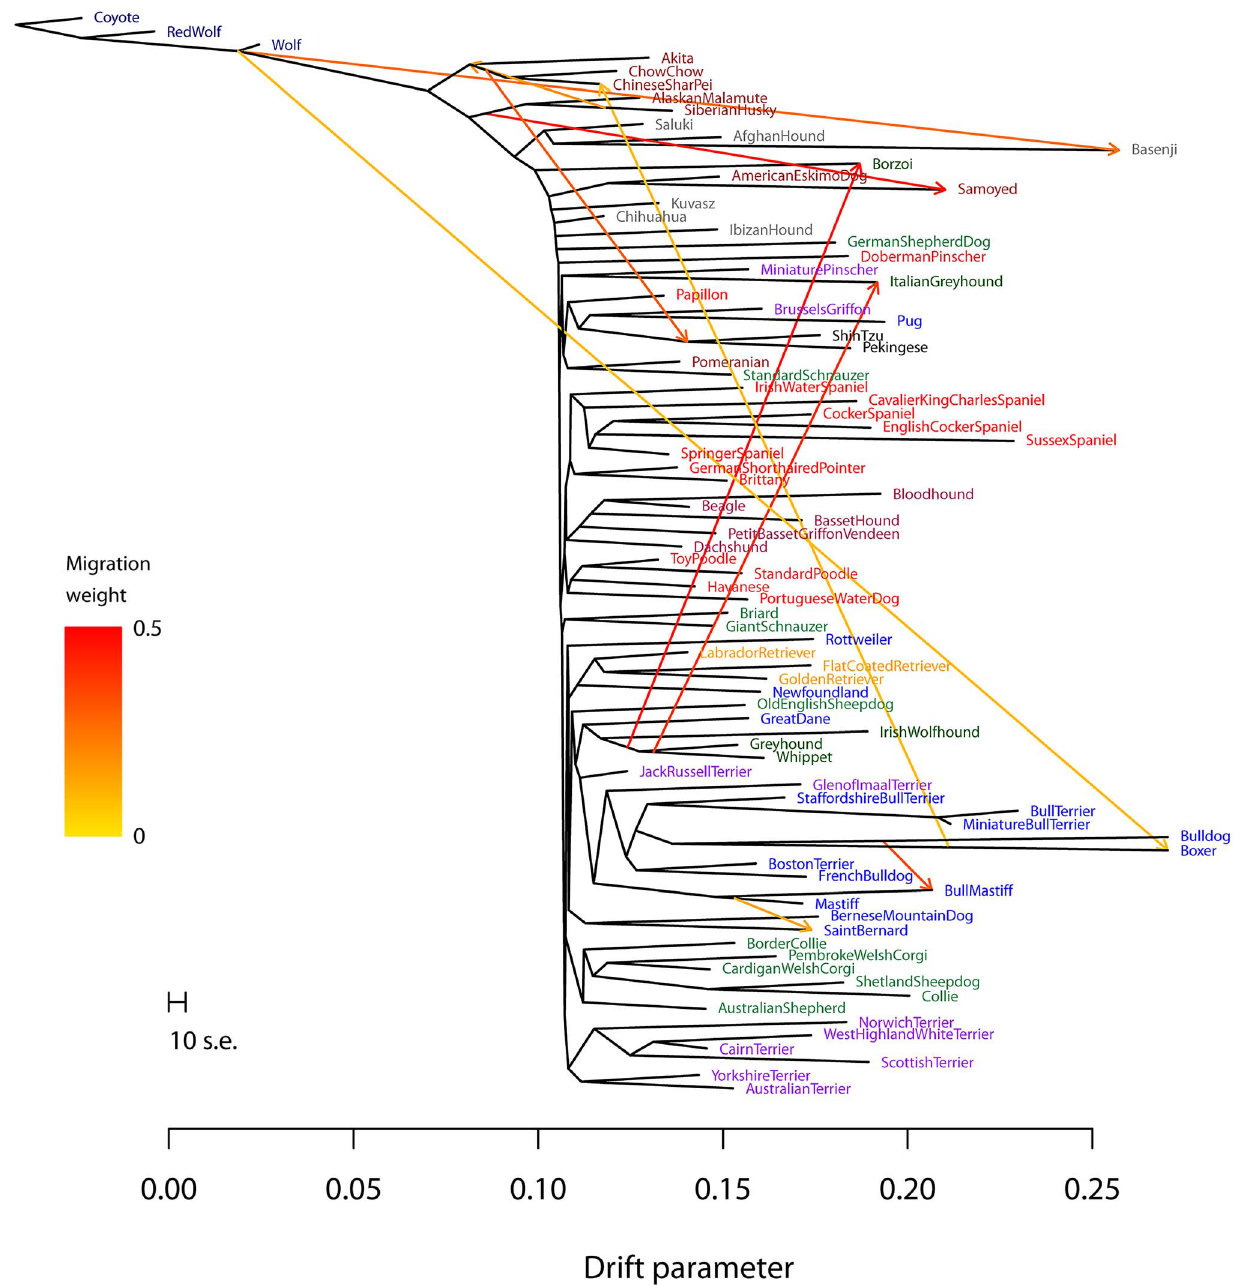
Figure 6. Inferred dog graph. Plotted is the structure of the graph inferred by TreeMix for dog populations, allowing ten migration events. Migration arrows are colored according to their weight. The scale bar shows ten times the average standard error of the entries in the sample covariance matrix ( ^ WW ). See the main text for discussion. The residual fit from this graph is presented in Figure S13.